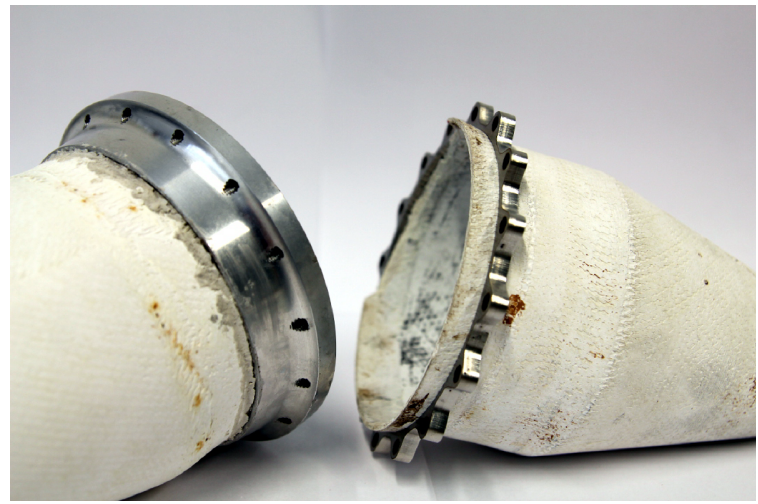
Figure 31. Comparison of the revised ( left ) with the clamping ring ( right ), which has been proven to be inadequate in